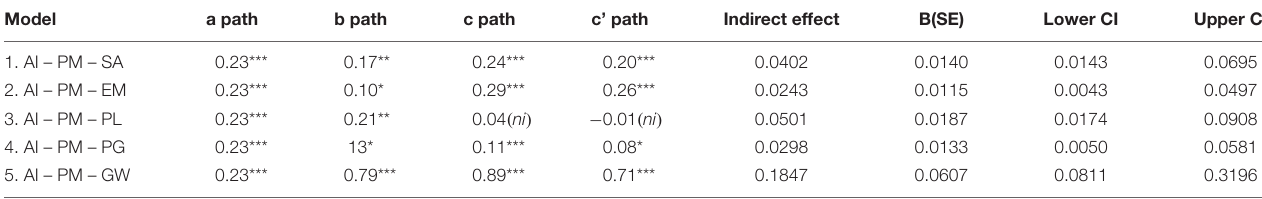
TABLE 3 | Significant outcomes of mediation analyses from acceptance of illness to well-being assessing indirect effects of presence of meaning ( N = 102).